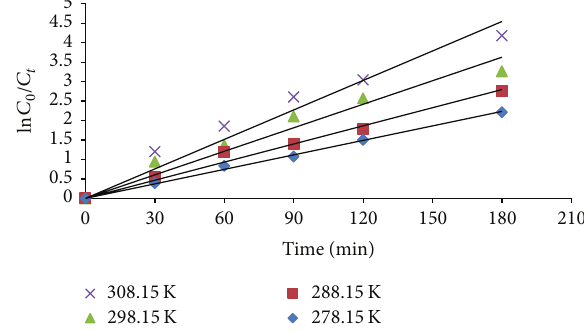
Figure 3: Effect of temperature on the degradation rate of